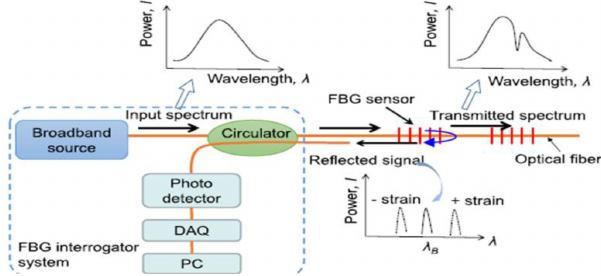
Figure 3. Fiber Bragg grating system, adopted from Xu et al. (2017). Table 1. Scaling laws for applicable physical properties.